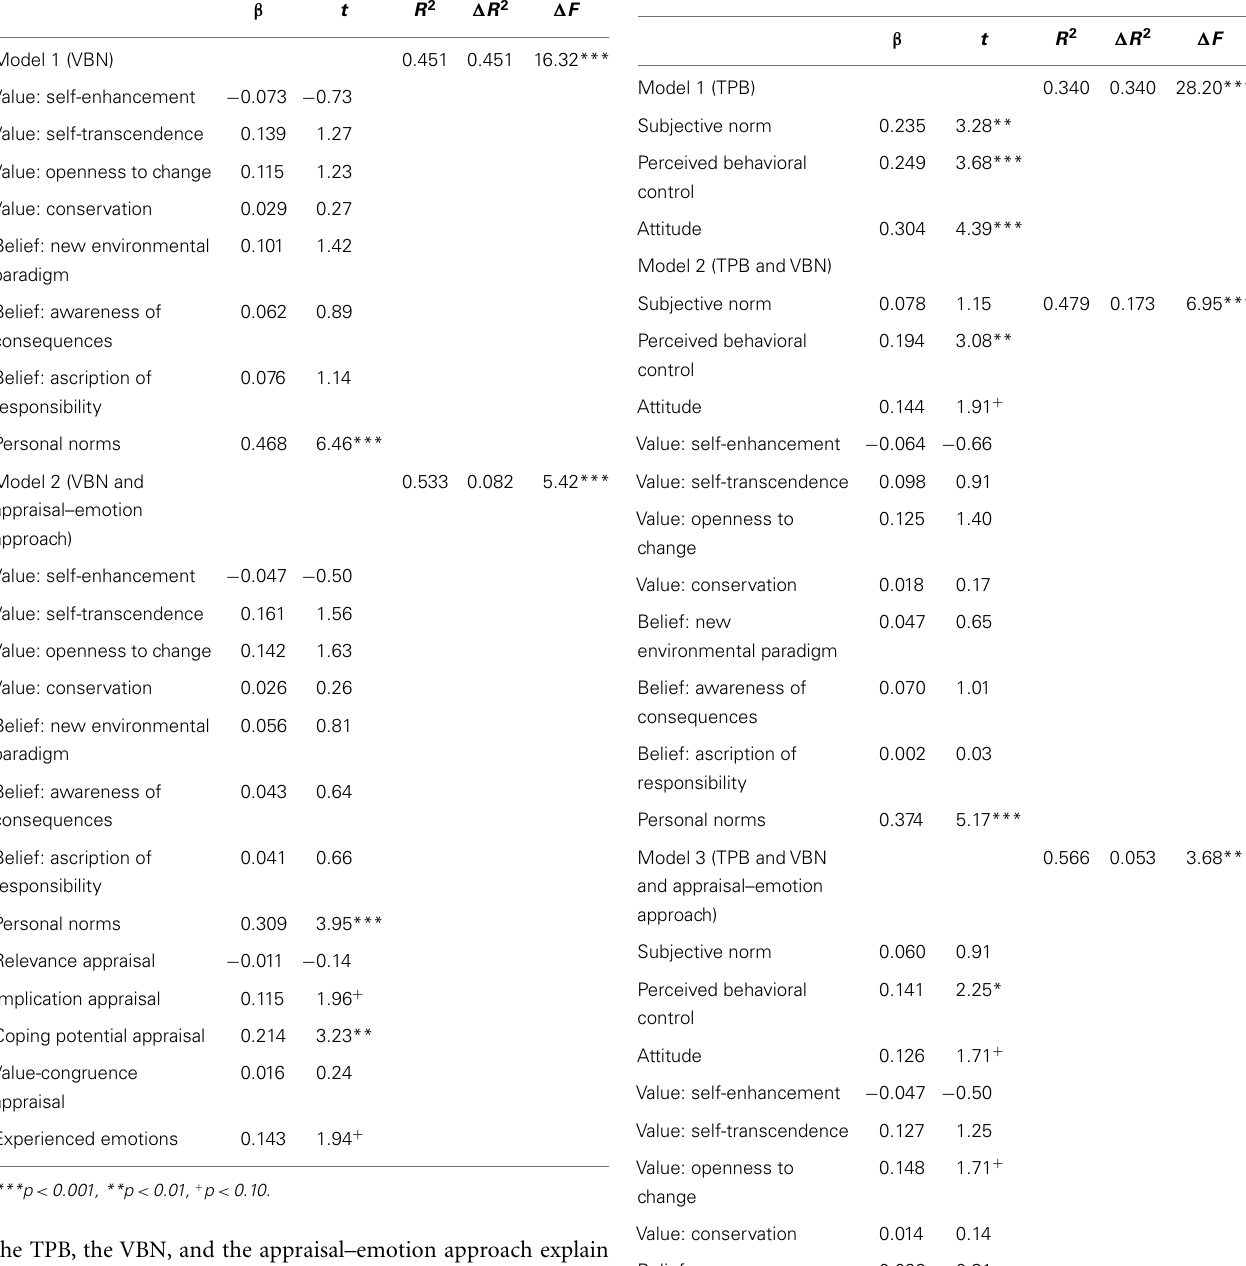
Table 6 | Hierarchical regression results forVBN (model 1) and the combined variables fromVBN and the appraisal–emotion approach (model 2, N = 168) .